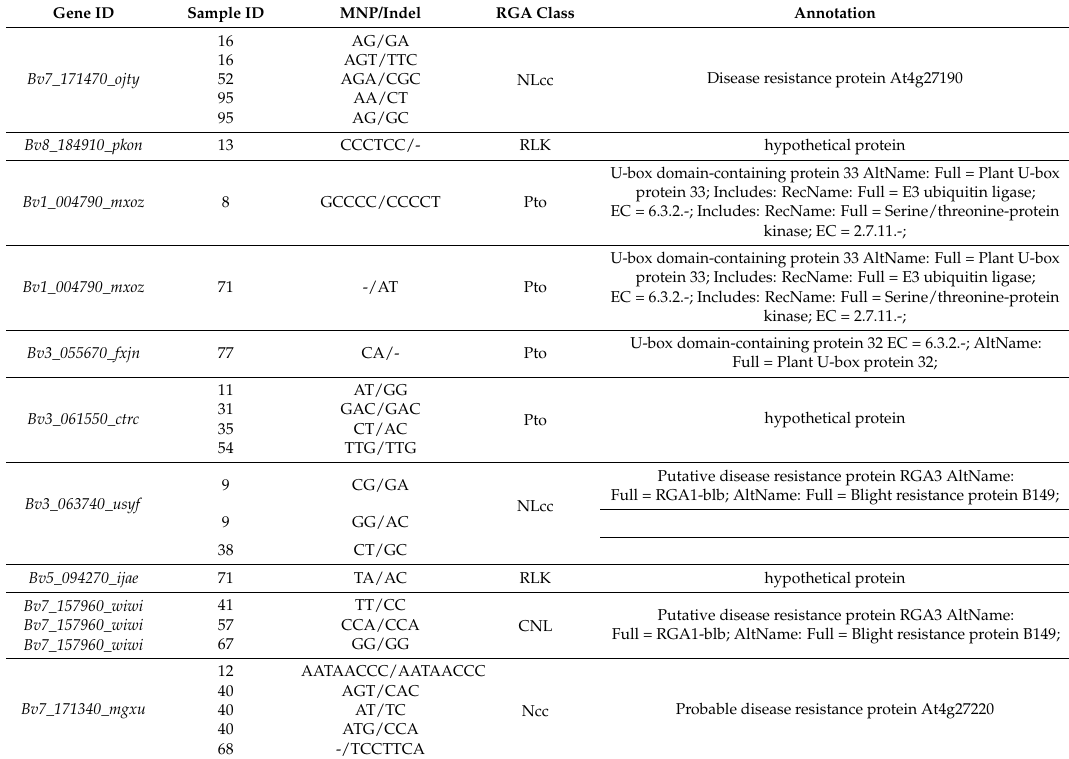
Table 3. List of unique MNPs and Indels (insertion/deletion) detected in 21 RGAs among 96 individuals.